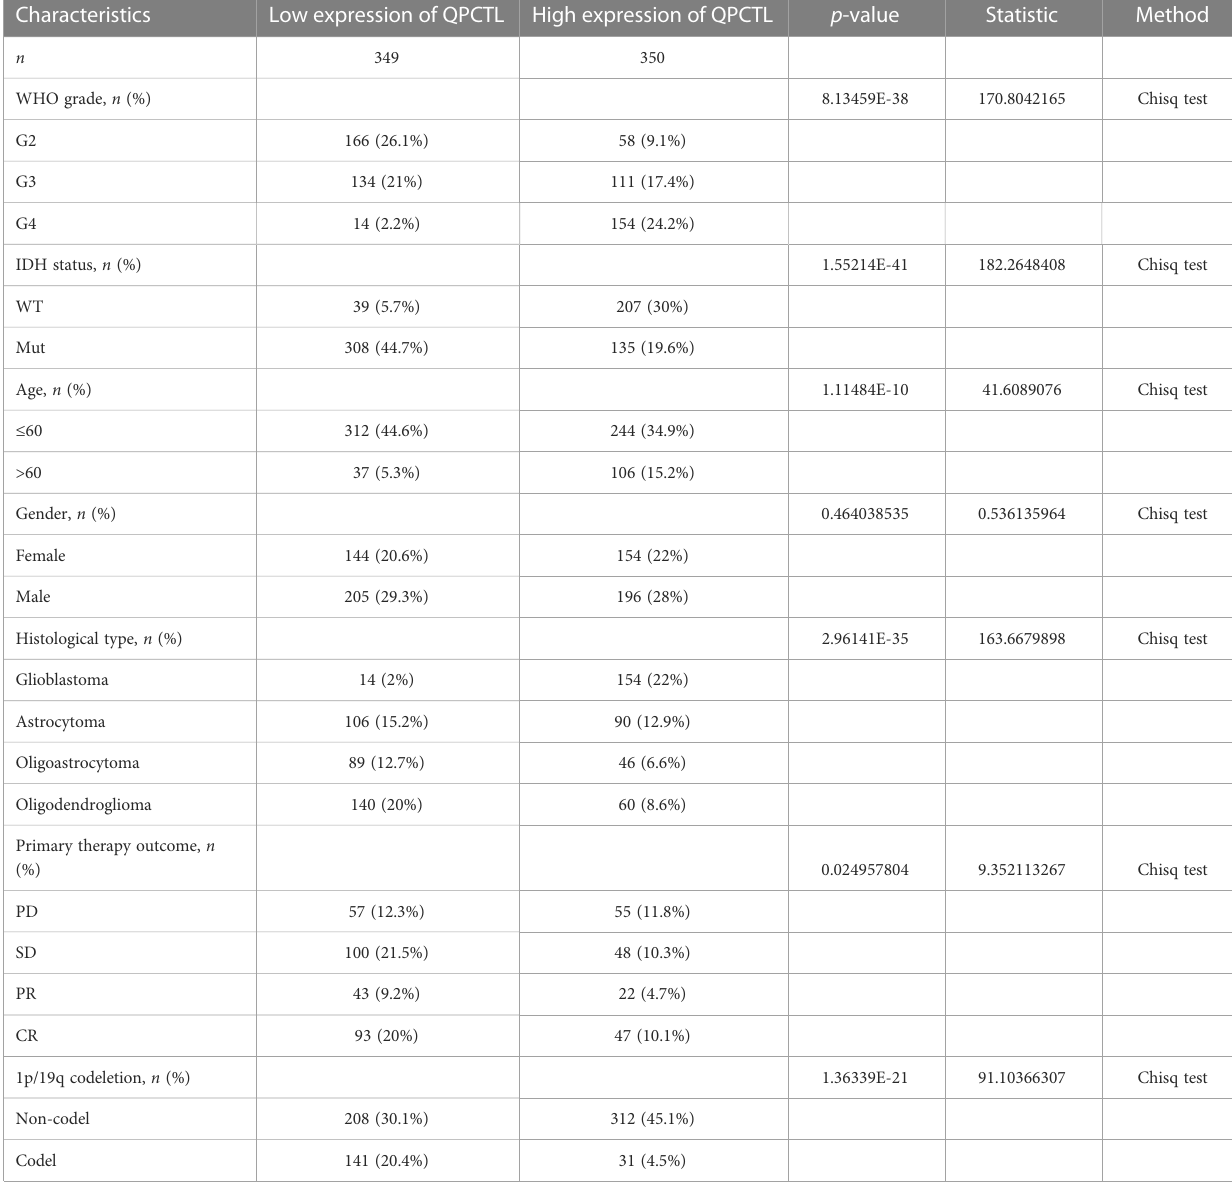
TABLE 1 The clinical characteristics of the glioma patients in the test and validation sets. Characteristics Low expression of QPCTL High expression of QPCTL p -value Statistic Method 349